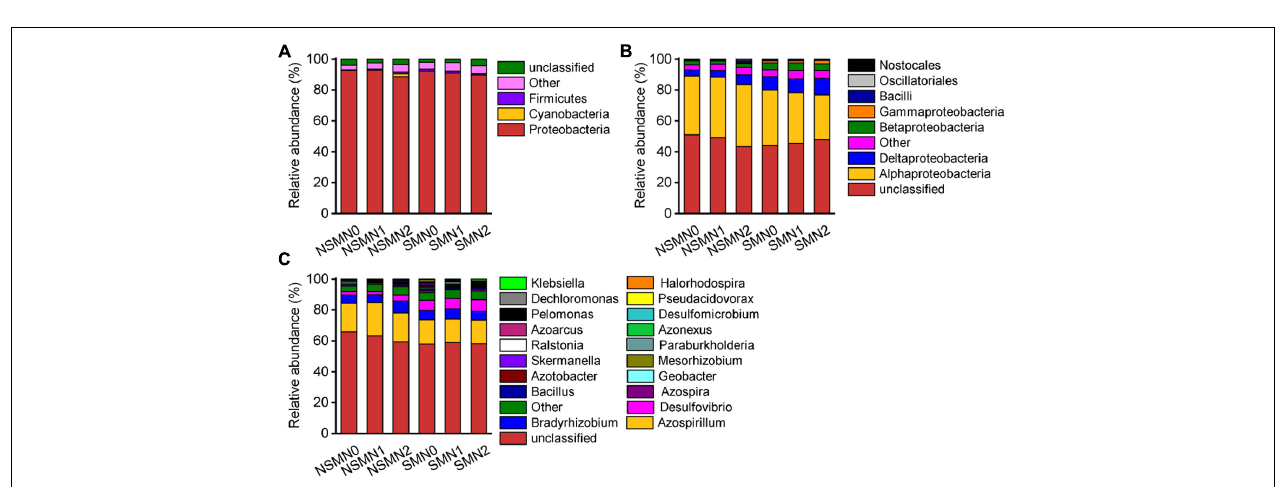
FIGURE 4 | The community composition of diazotrophs in wheat rhizosphere soil under straw mulching and nitrogen fertilization treatments. (A) Phylum level; (B) class level; (C) genus level. NSM, no straw mulching; SM, straw mulching; N0, no nitrogen; N1, 120 kg N ha − 1 ; N2, 180 kg N ha − 1 .